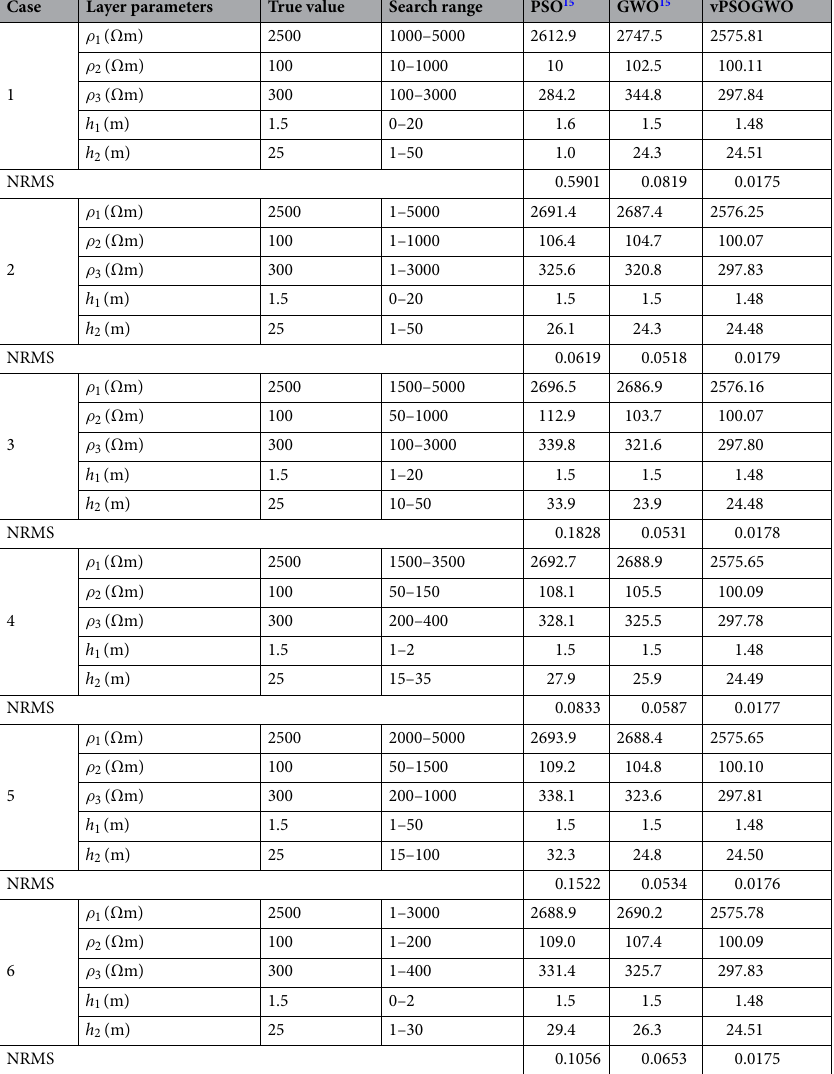
Table 2. Stability and sensitivity of 10% noisy synthetic DC resistivity sounding data.